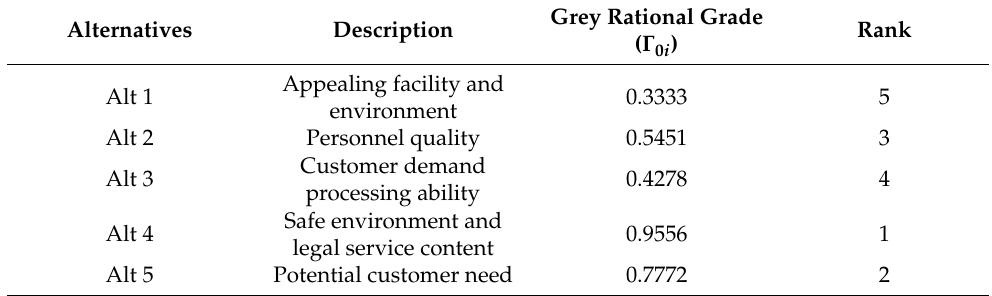
Table 17. Grey rational